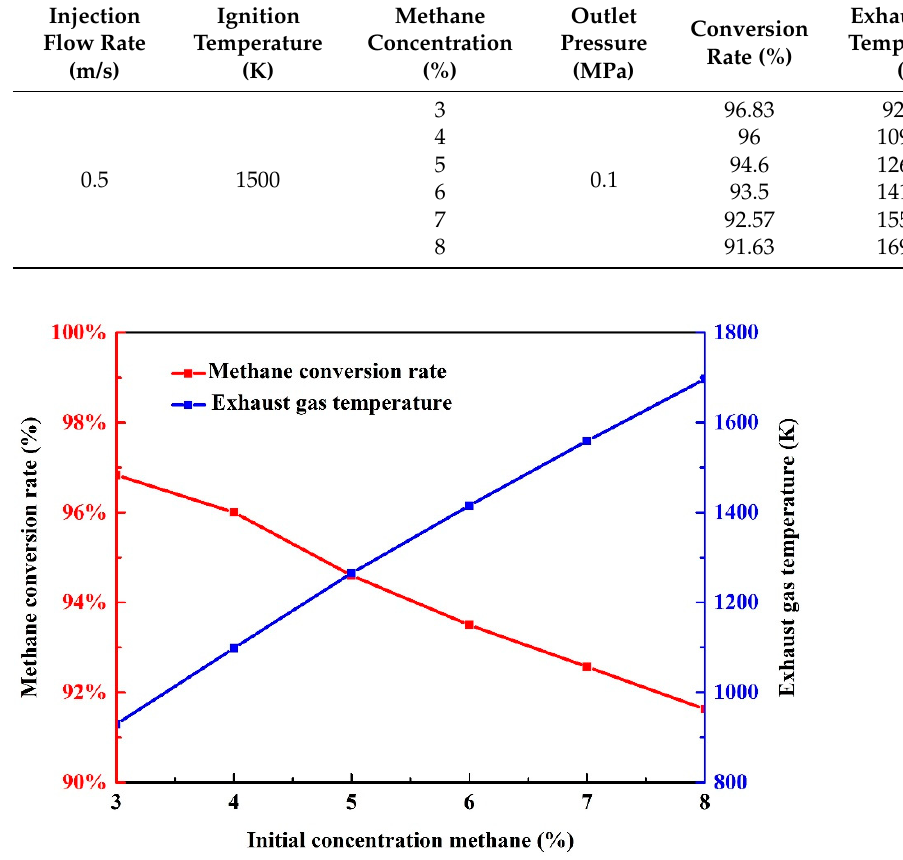
Figure 6. Conversion rate and exhaust gas temperature under different methane concentrations.